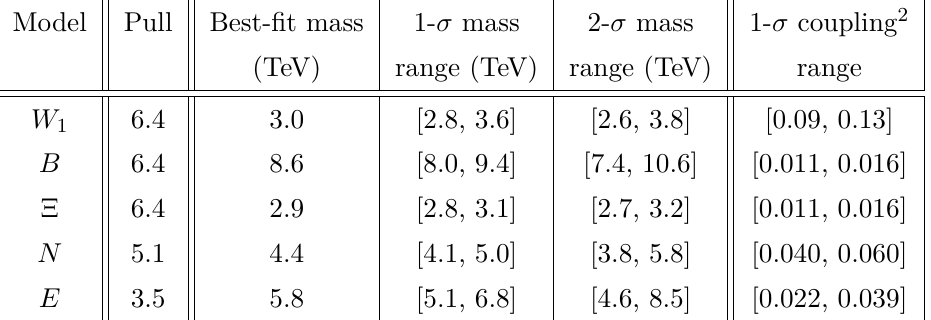
Table 4 . Single-field models that can improve on the SM fit when the CDF measurement of m W is included, showing their respective pulls, the best-fit masses and their 1- and 2- σ ranges assuming unit couplings, and the 1- σ coupling ranges assuming masses of 1 TeV.